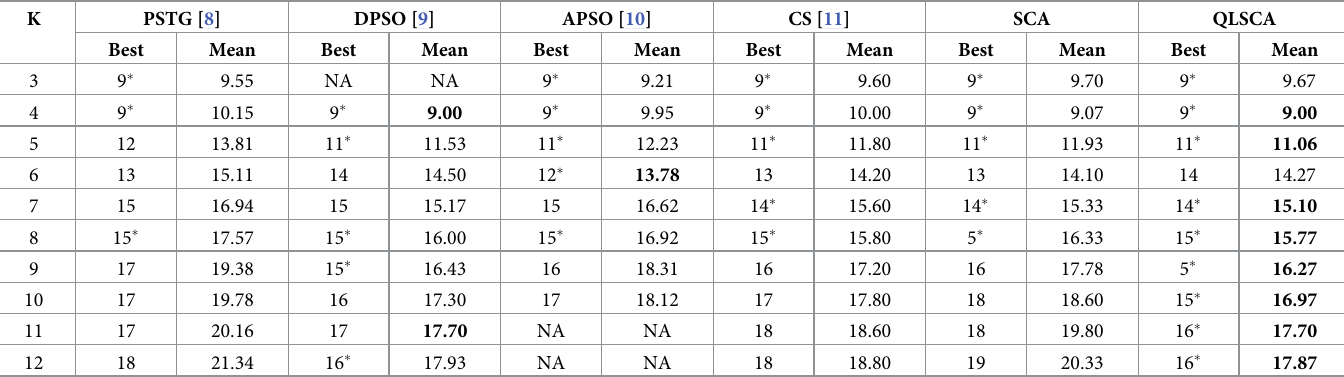
Table 4. Size performance for CA ( N ;2, 3 k ) where k is varied from 3 to 12.